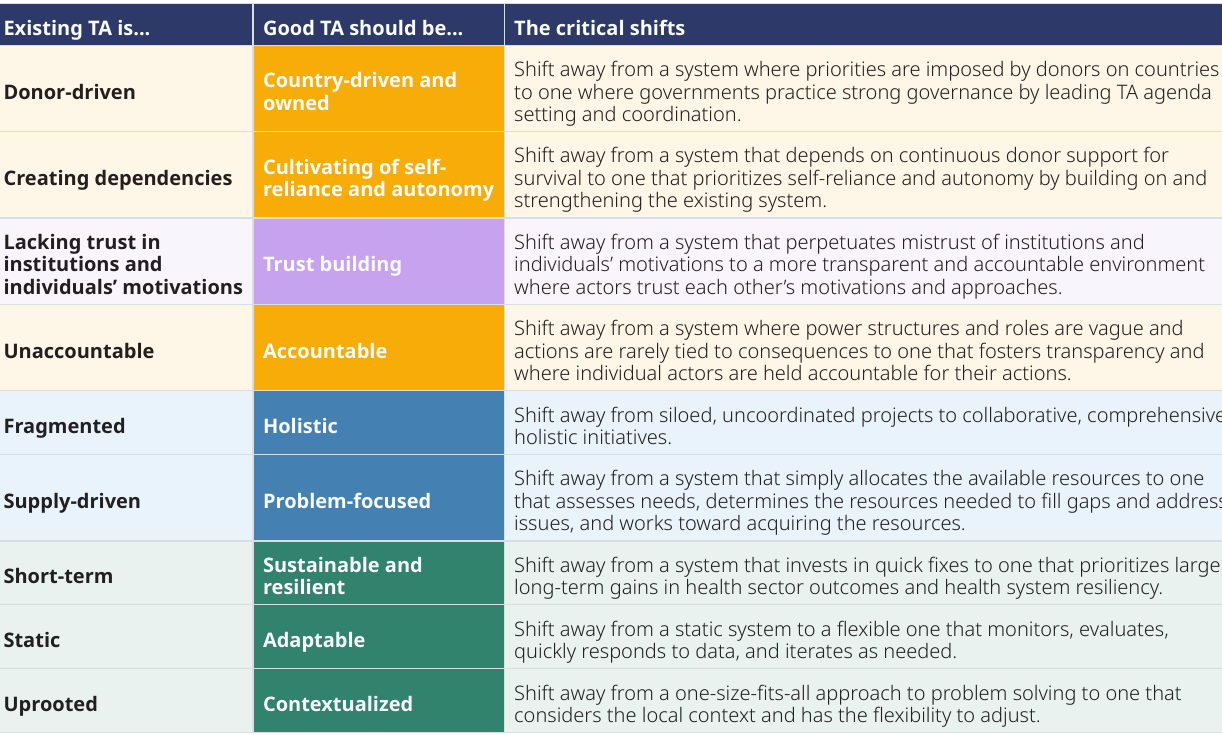
Table 1. Critical shifts to transform technical assistance. Existing TA is... Good TA should be...